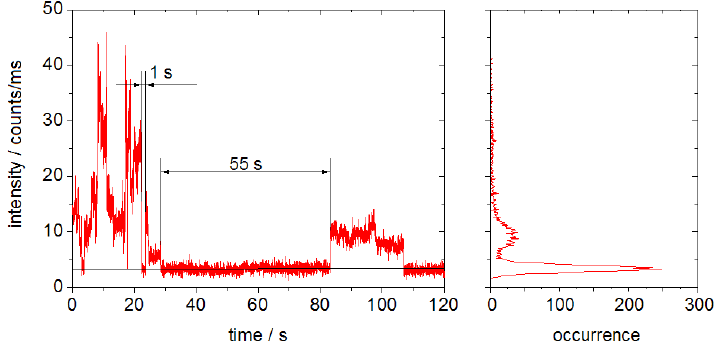
Figure 7. An example of a single molecule fluorescence trajectory and intensity histogram recorded at 33°C. The time trace is characterized by a long off periods. The black horizontal line shows the background level.